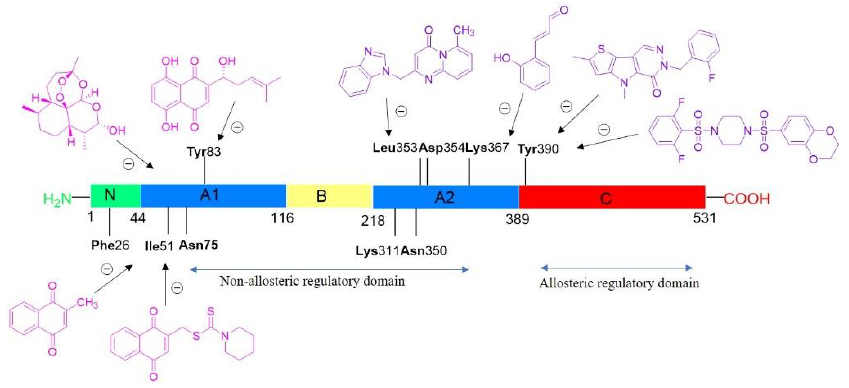
Figure 14. Some of the PKM2 activators and inhibitors binding PKM2 domains.